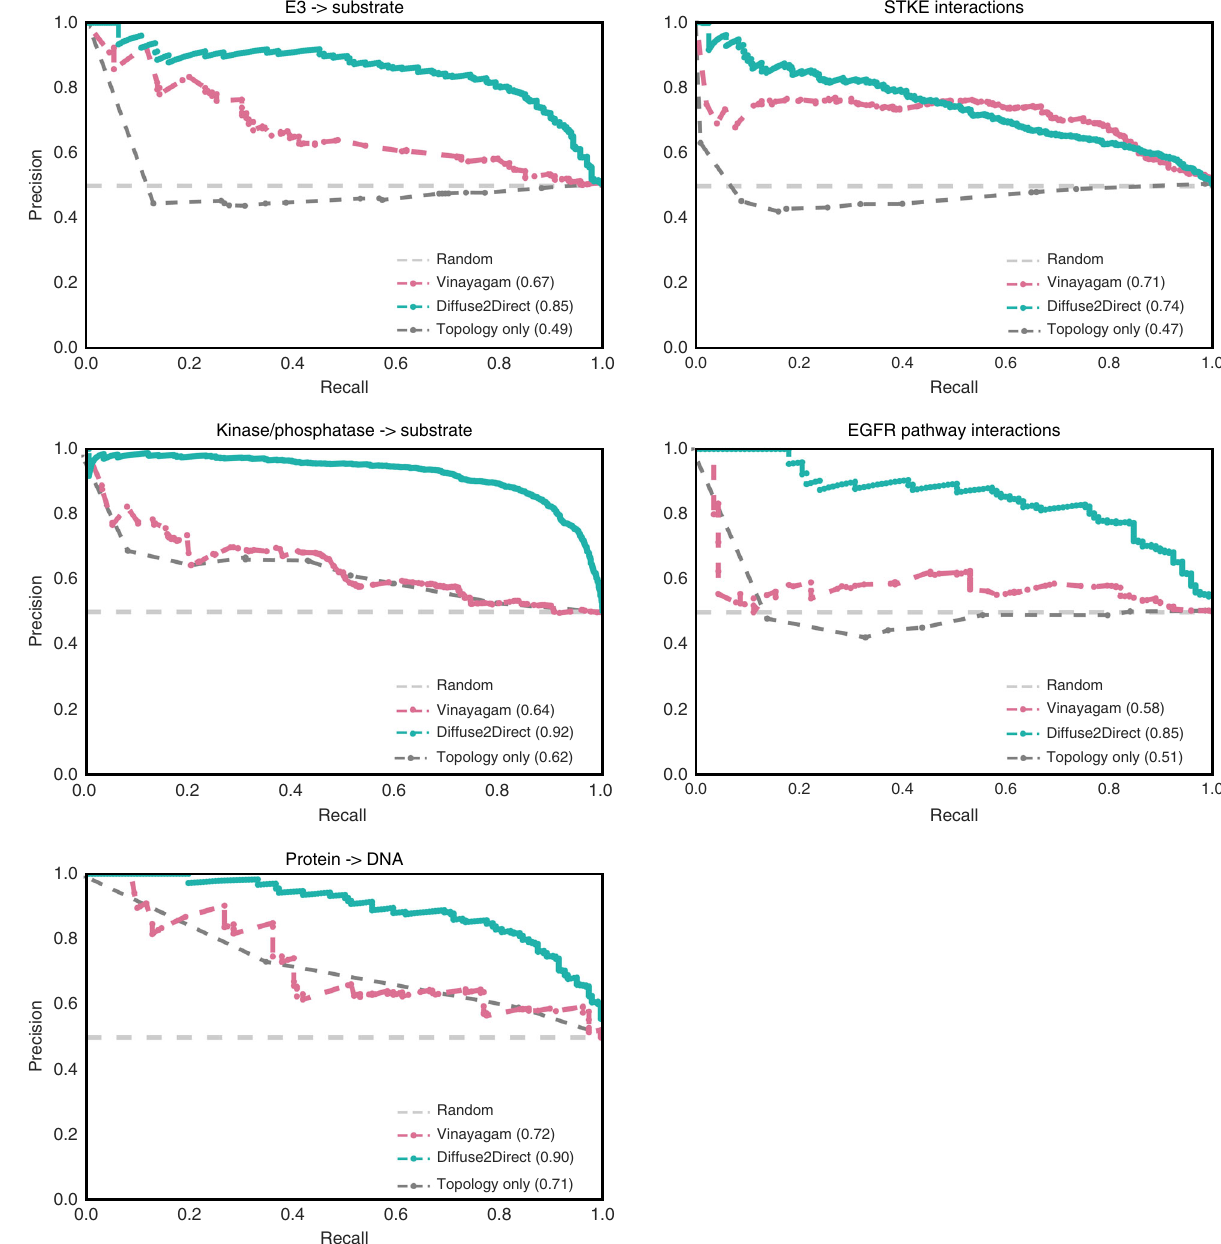
Fig. 3 Performance evaluation. Shown are cross-validation results comparing the directions inferred by Diffuse2Direct, Vinayagam et al. and a benchmark topology-based approach to subsets of interactions with known directionality: E3 ubiquitination interactions, kinases to their substrates (KPIs), protein – DNA interactions (PDIs), signal-transduction interactions in mammalians (STKE) and interactions from the well-studied EGFR pathway. The area under the precision-recall curve for each approach appears in